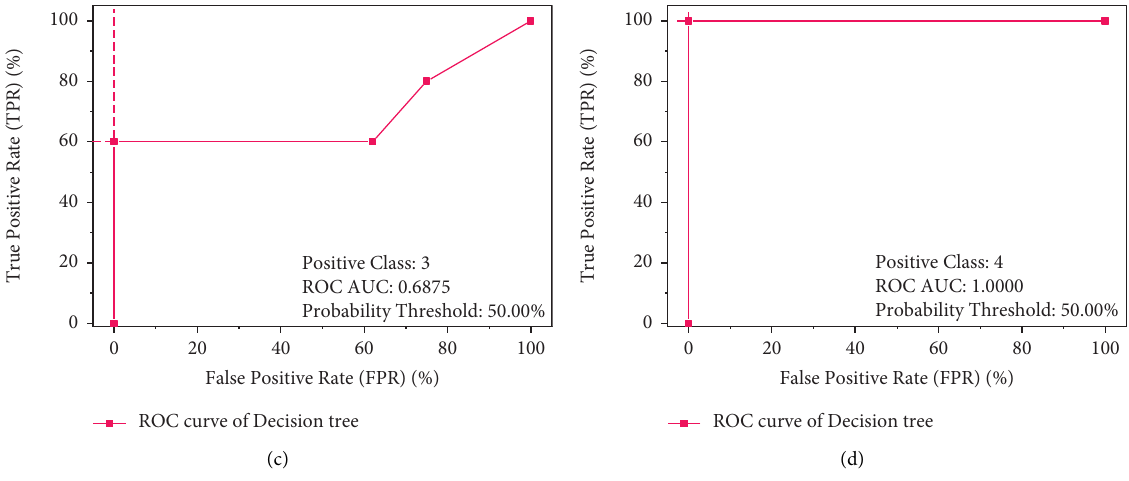
Figure 10: ROC curve of each classification test of the decision tree model.